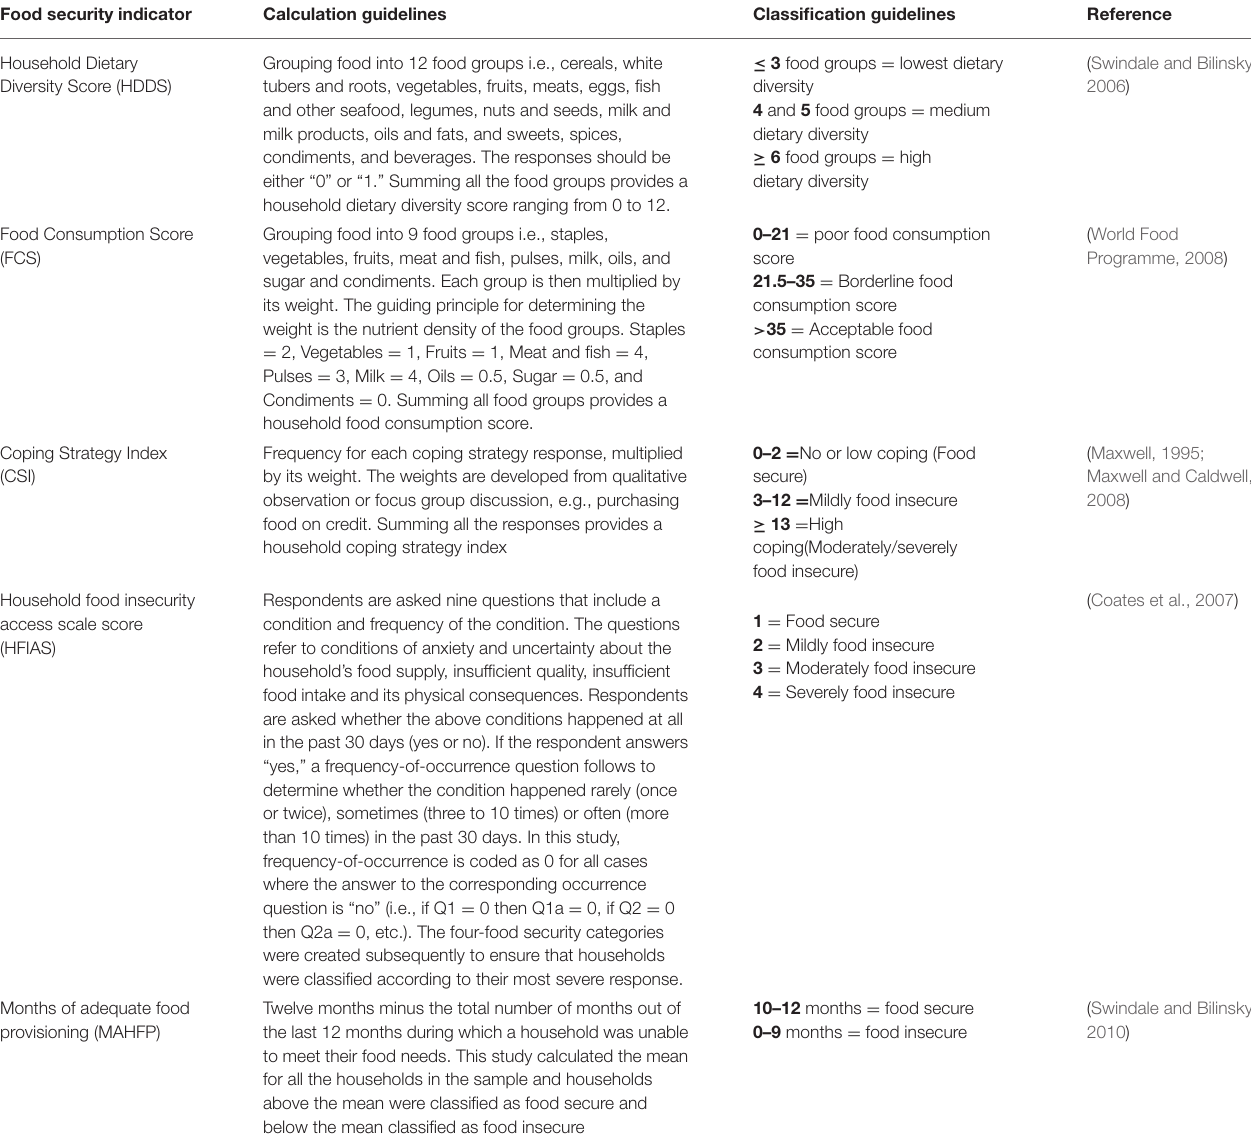
TABLE 1 | Calculation and classification for each food security indicator. Food security